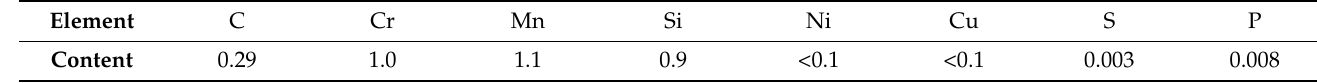
Table 1. Chemical composition of the 30 KhGSA steel, %wt.